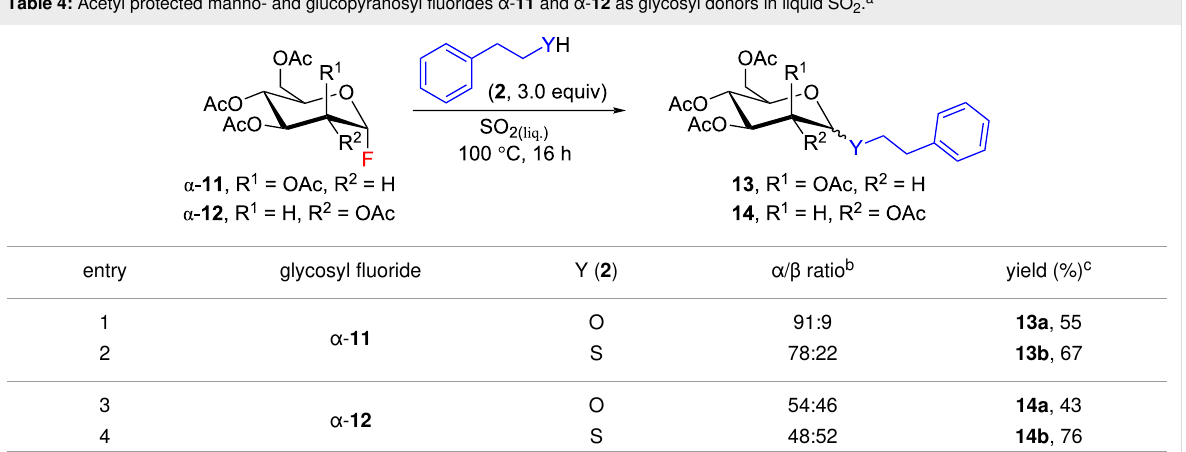
Table 4: Acetyl protected manno- and glucopyranosyl fluorides α - 11 and α - 12 as glycosyl donors in liquid SO 2 . a